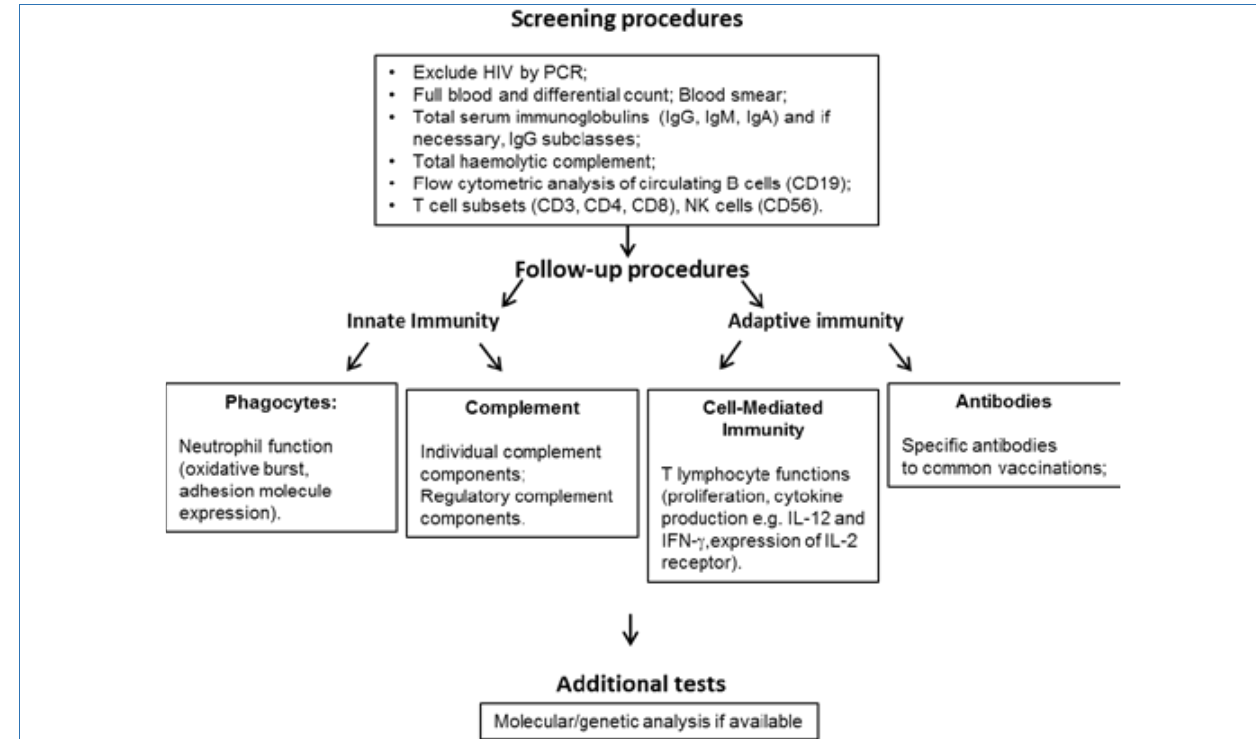
Figure 1. Diagnostic algorithm for